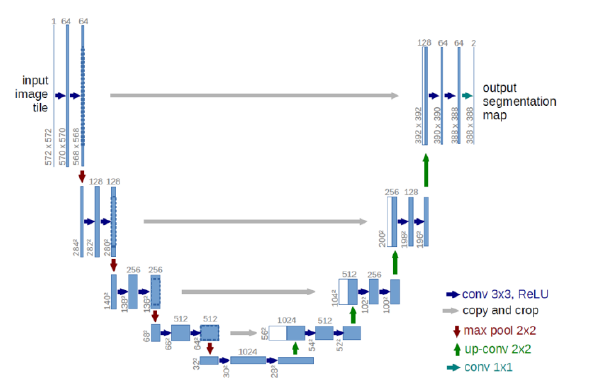
Figure 1. The original architecture of U-Net